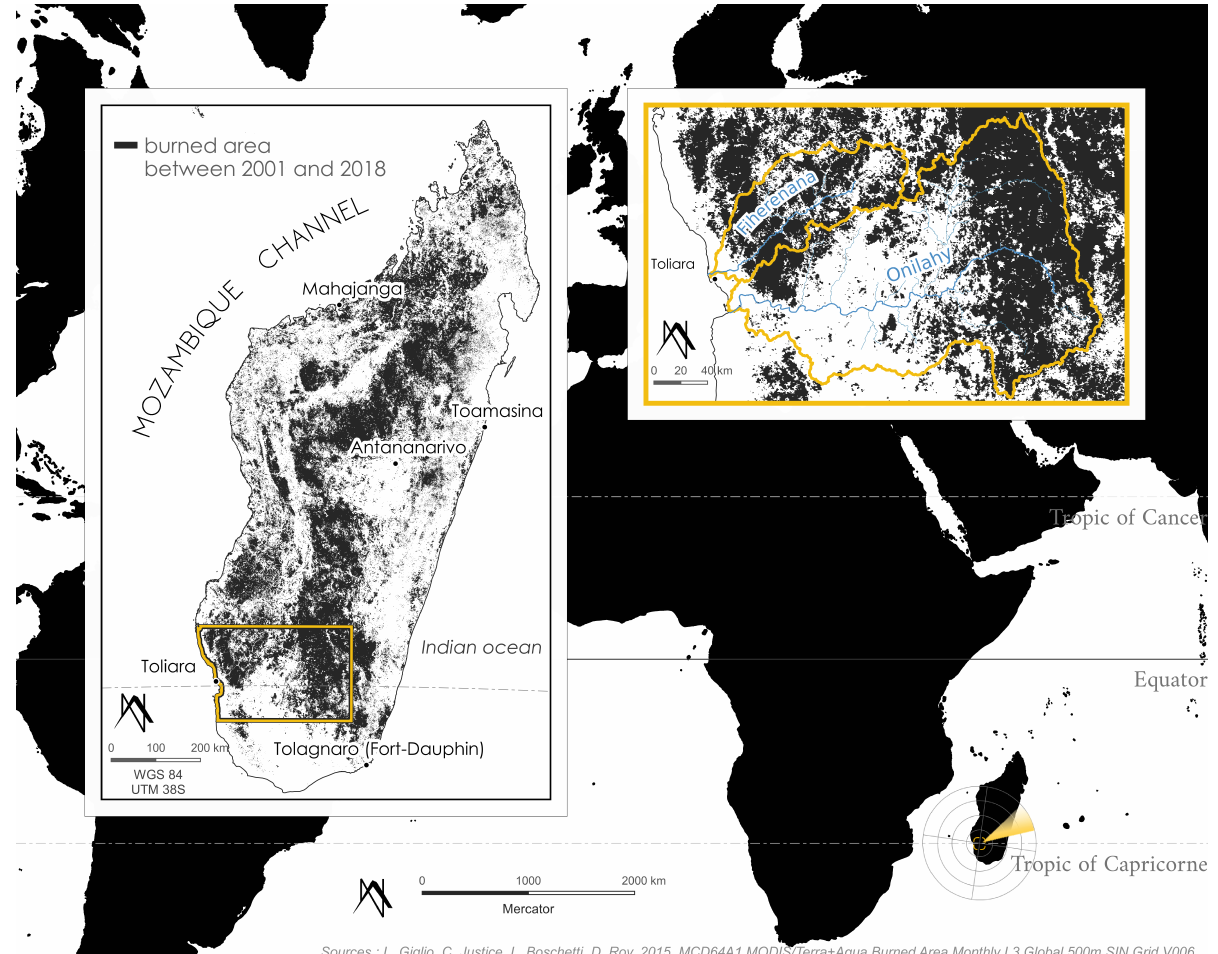
Figure 1. Background: Location of the study area in the world, the southwest of Madagascar. Foreground- left : Burned areas at least once in the period 2001–2018 in Madagascar. Foreground- right : Burned areas in the Fiherenana and Onilahy watersheds, southwestern